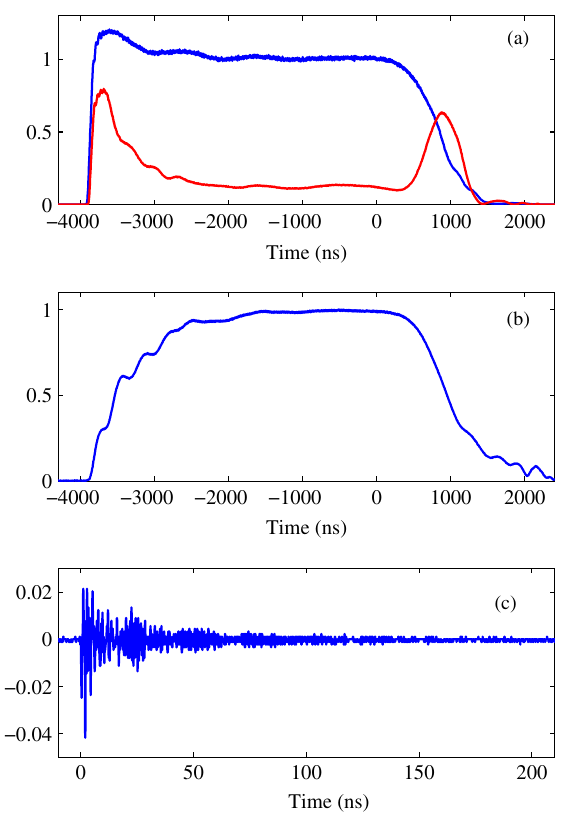
FIG. 2. Typical waveforms without breakdown. (a) Envelopes of the normalized input (blue line) and reflected (red line) rf pulse. (b) Envelope of the normalized pickup signal. (c) The Faraday cup signal in amperes as excited by